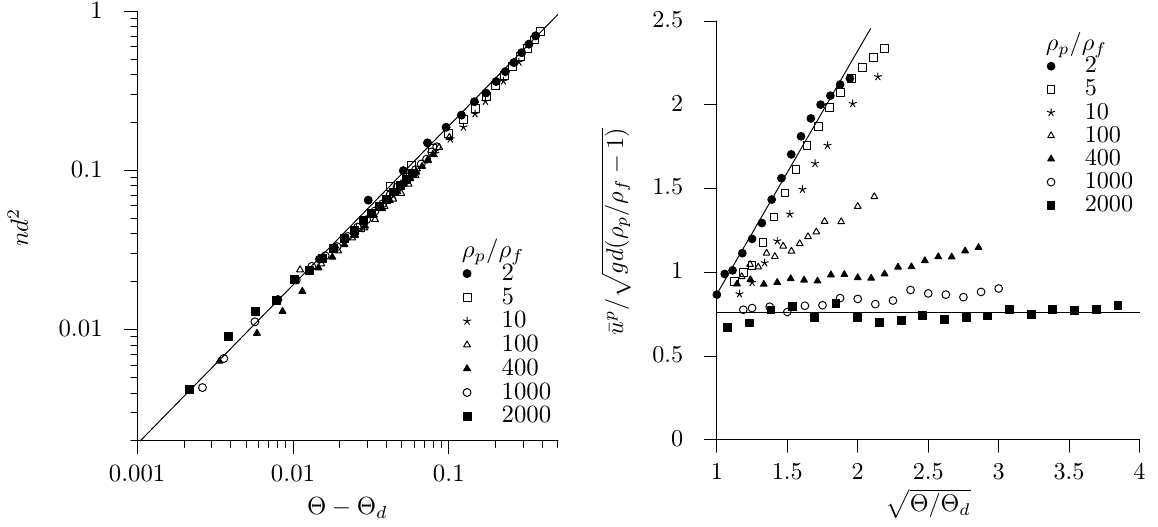
Fig. 4. (a) Number of transported grains per unit area n and (b) mean velocity of these grains ¯ u p as functions of the Shields number 2 , for different values of the density ratio ρ p /ρ f (see legend).